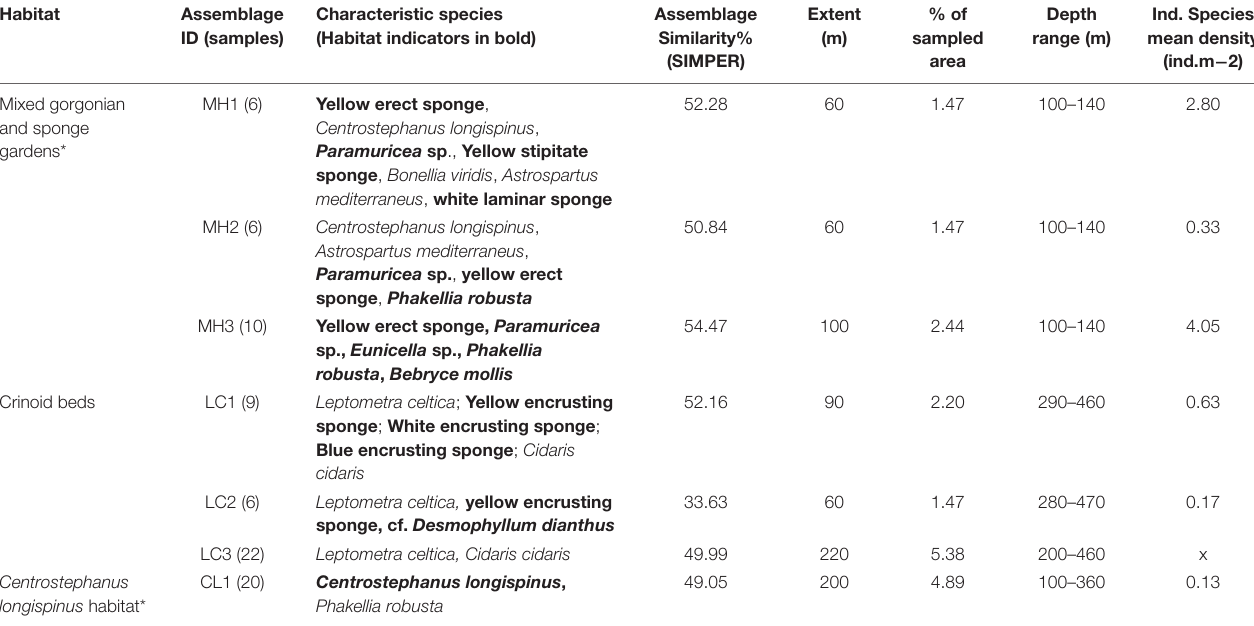
TABLE 4 | Assemblages classified as mixed communities and other habitats of potential conservation concern in the São Vicente Submarine Canyon. Habitat Assemblage Characteristic species ID (samples) (Habitat indicators in